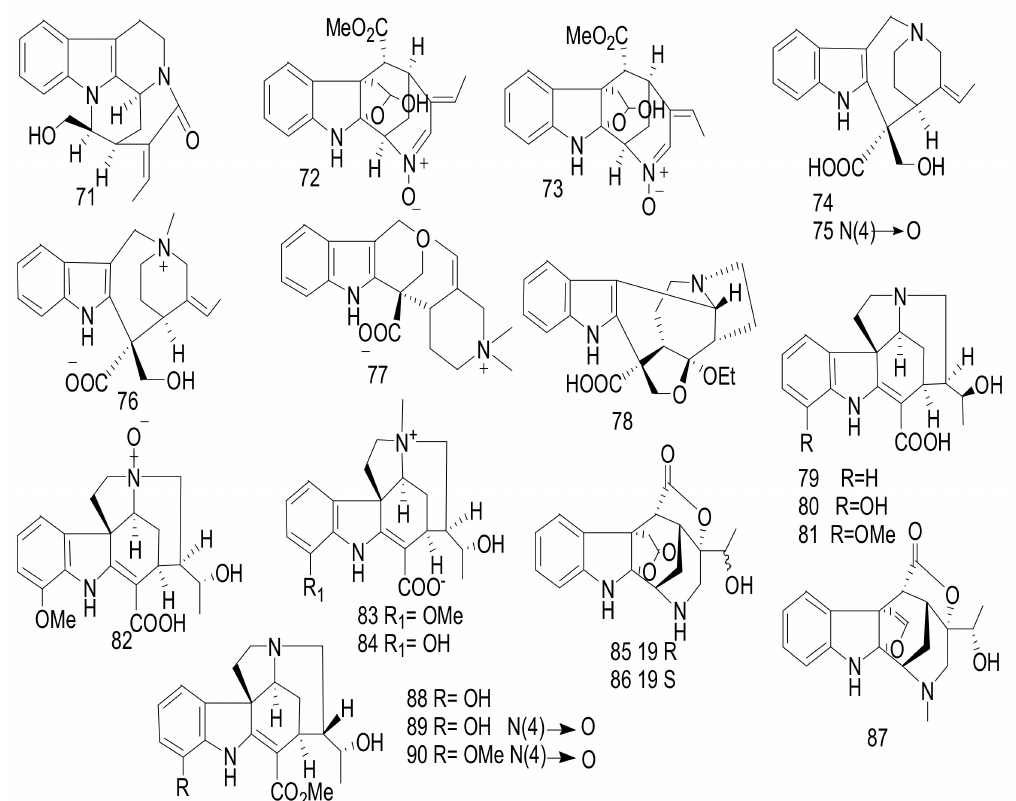
Figure 11. Compounds 71 – 90 .